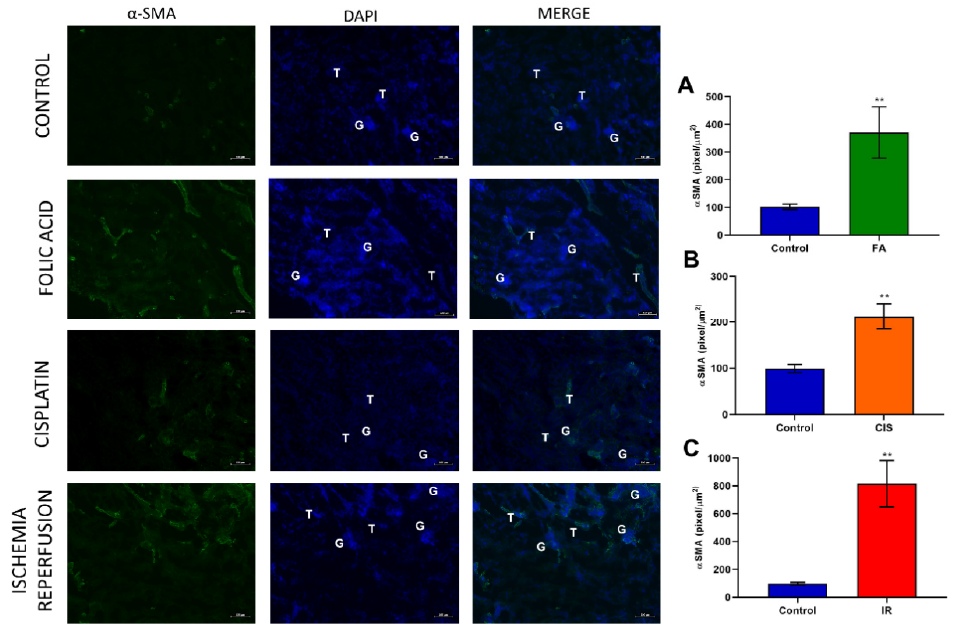
Figure 4. Effects of fibrogenesis on kidney damage. The analysis was performed by anti- α -SMA using a fluorescent microscope after different kidney injury protocols. Green color indicates α -SMA positive staining. Blue color indicates nuclei stained with DAPI and the third column indicates the merge of α -SMA and DAPI. A-SMA quantification ( A – C ) after folic acid (FA) treatment, cisplatin (CIS) treatment, and ischemia reperfusion (IR) surgery. G indicates glomeruli and a T indicates tubules. Scale bars = 100 µ M. Data presented as mean ± SEM; n = 6. Two-tailed Student ´ s t-test. ** p <